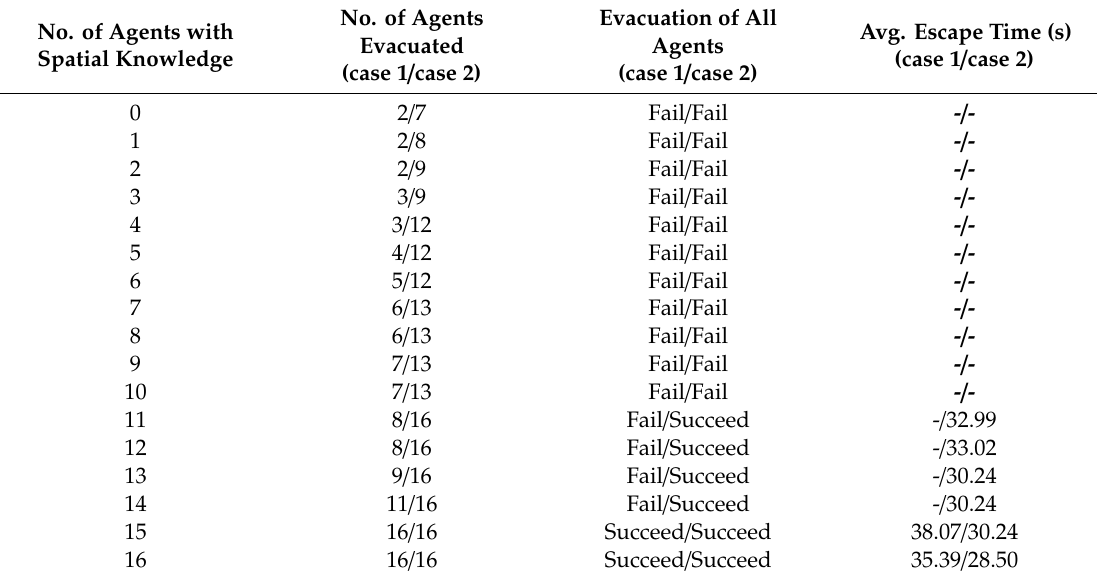
Table 1. E ff ect of spatial knowledge on evacuation